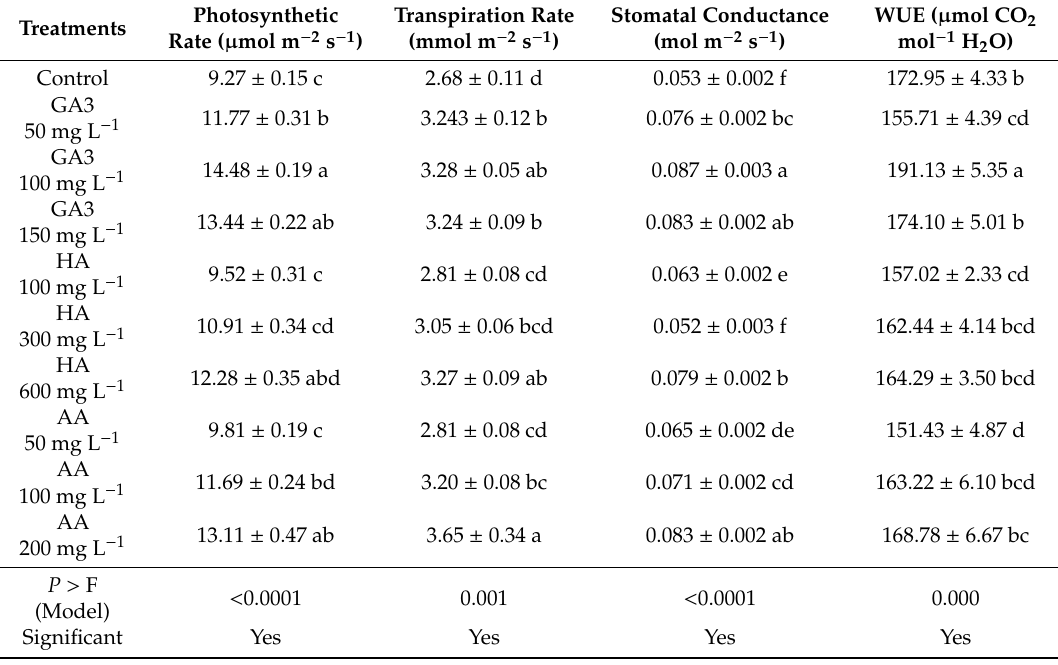
Table 1. E ff ect of exogenous application of bioregulators on physiological attributes of Gazania . Treatments